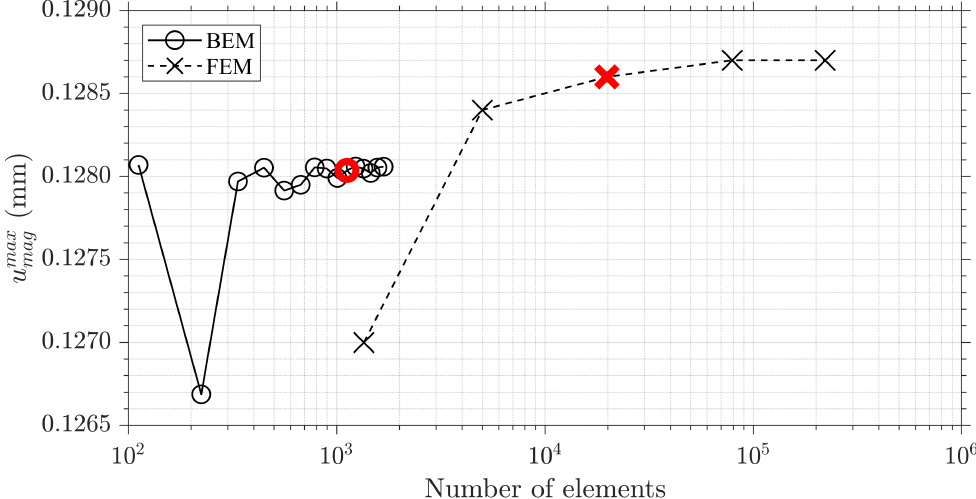
Figure 17. Mesh convergence with the Boundary Element Method (BEM) and the Finite Element Method (FEM). The BEM and FEM meshes considered to have reached convergence are shown as red markers.